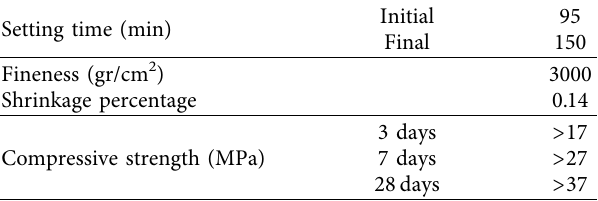
Table 1: Physical properties of cement.